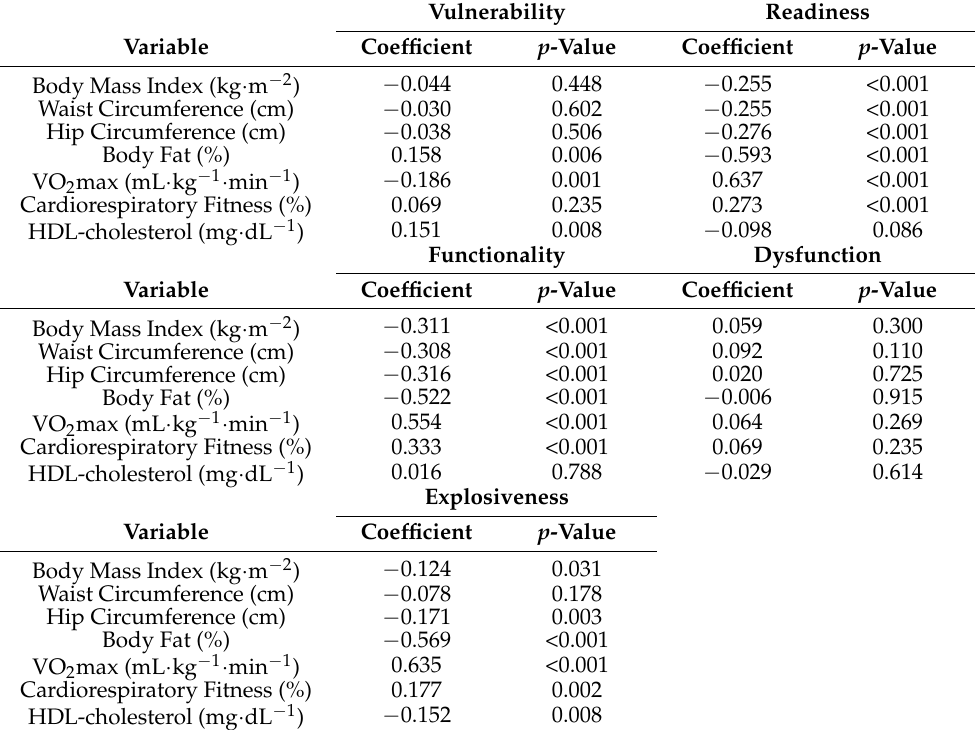
Table 3. Pearson product–moment correlation coefficients ( r ) between health-related fitness param- eters and five functional movement screening scores (i.e., readiness, explosiveness, functionality, dysfunction, and vulnerability) and their respective levels of statistical